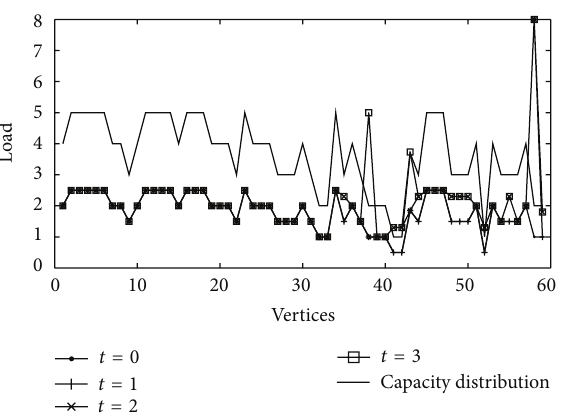
Figure 7: Load distributions of the evolution process in Case II(3).